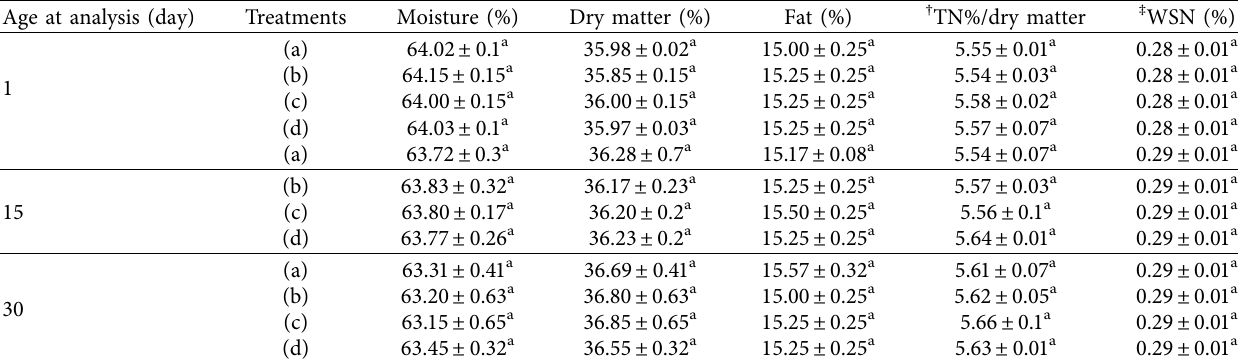
Table 3: Chemical composition ⁂ of Iranian UF ∗ cheese ∗∗ treated by KCl and NaCl during 30days of storage period. Age at analysis (day) Treatments